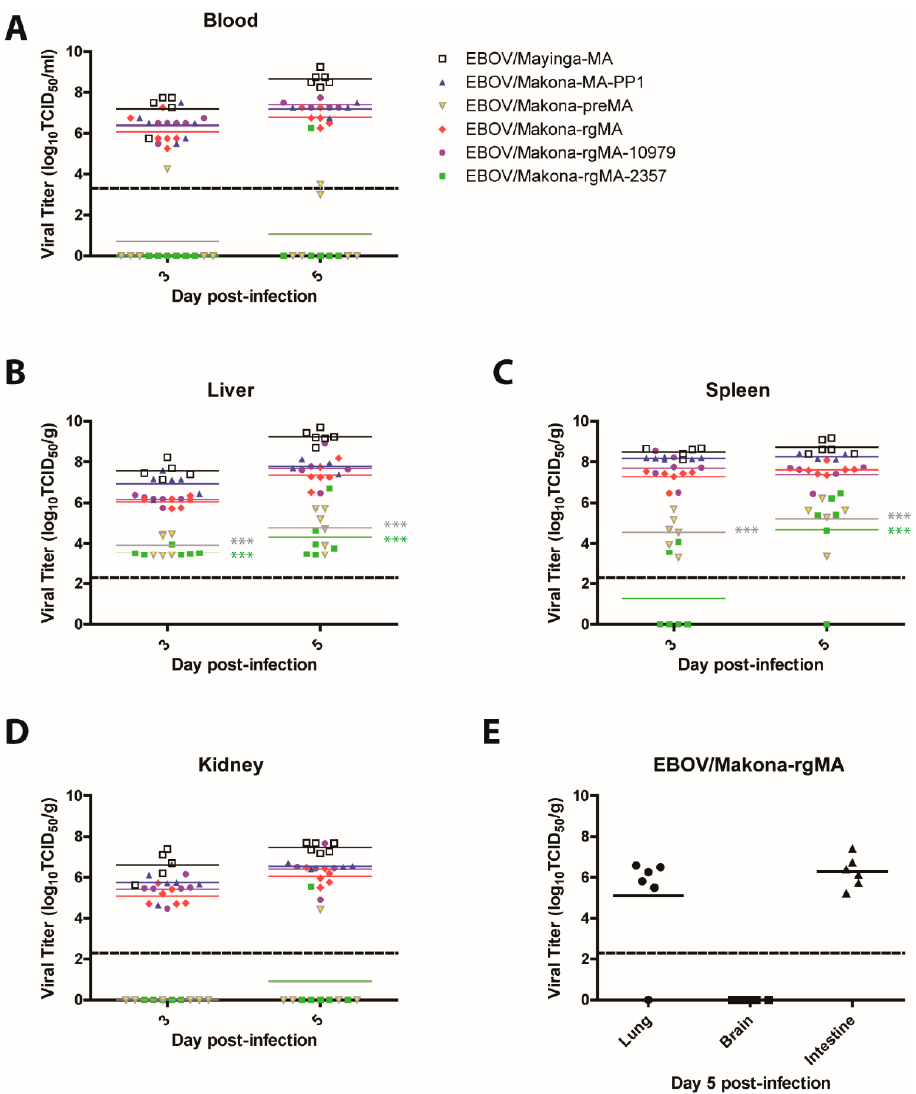
Figure 2. Viremia and viral replication in tissues of mice that were infected with mouse-adapted EBOV. Groups of mice ( n = 6) were infected intraperitoneally with 10 PFU of either EBOV / Mayinga-MA, EBOV / Makona-MA-PP1, EBOV / Makona-preMA, EBOV / Makona-rgMA, or the two single